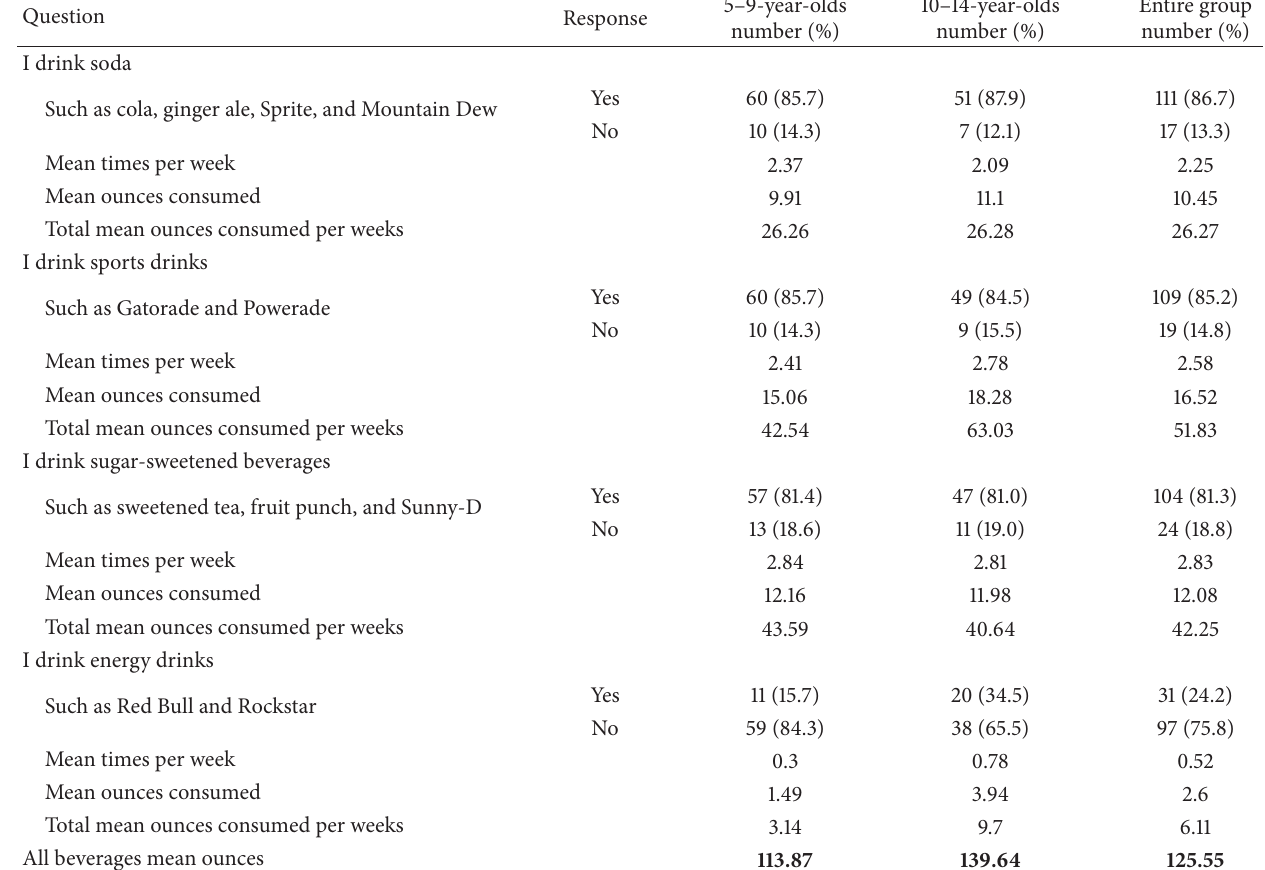
Table 1: Typical consumption of SSBs in youths attending a summer